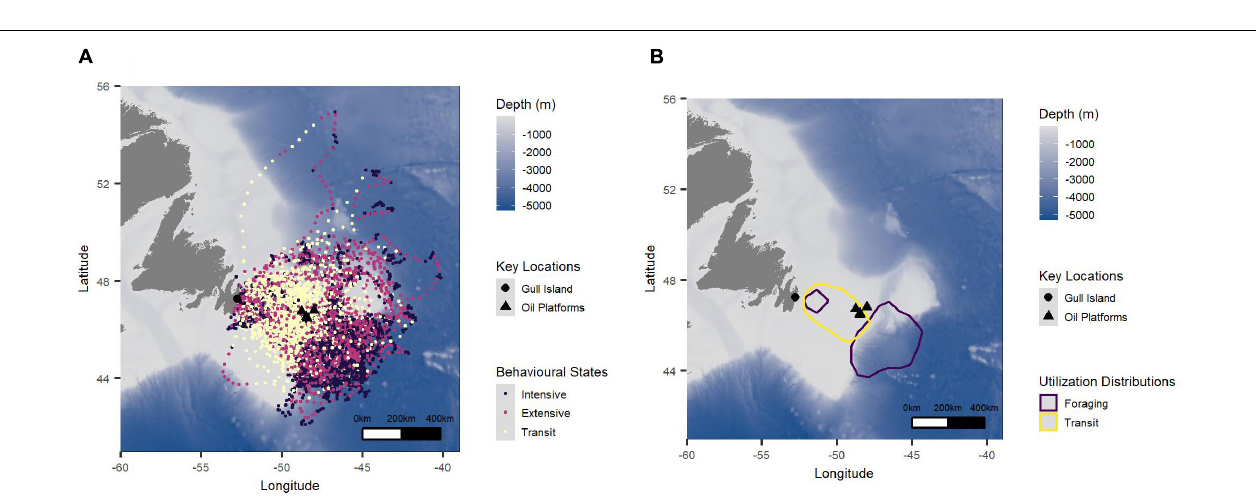
FIGURE 3 | The full Utilization Distributions (50%: purple, 64%: teal, 95%: yellow) for Leach’s Storm-Petrels breeding on Gull Island, Witless Bay, Newfoundland and Labrador, Canada from 2016 to 2021. Note that the 64% Utilization Distribution includes all oil platforms. The large black triangles represent the oil platforms, and the large black circle represents Gull Island. The bathymetry is represented where darker blue indicates deeper water.